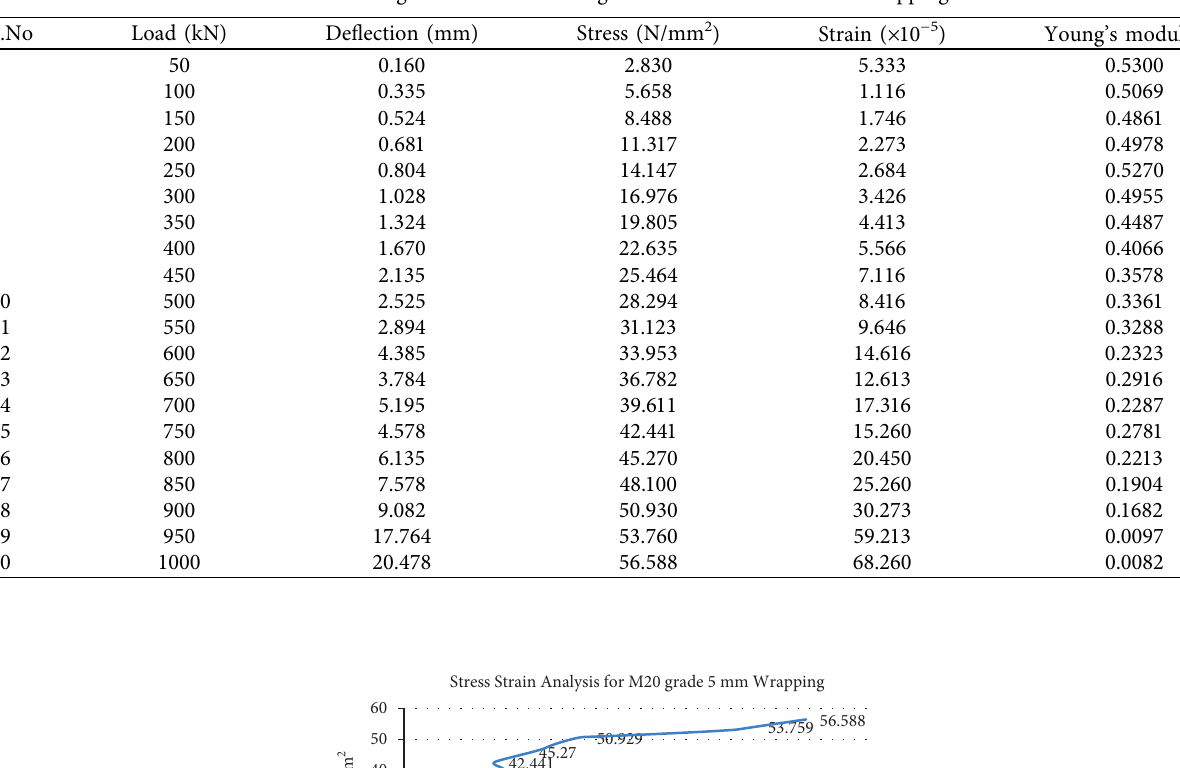
Figure 13: Stress-strain analysis for grade M20 with 3mm wrapping. Table 7: Young’s modulus for M20 grade of column with 5mm wrapping.